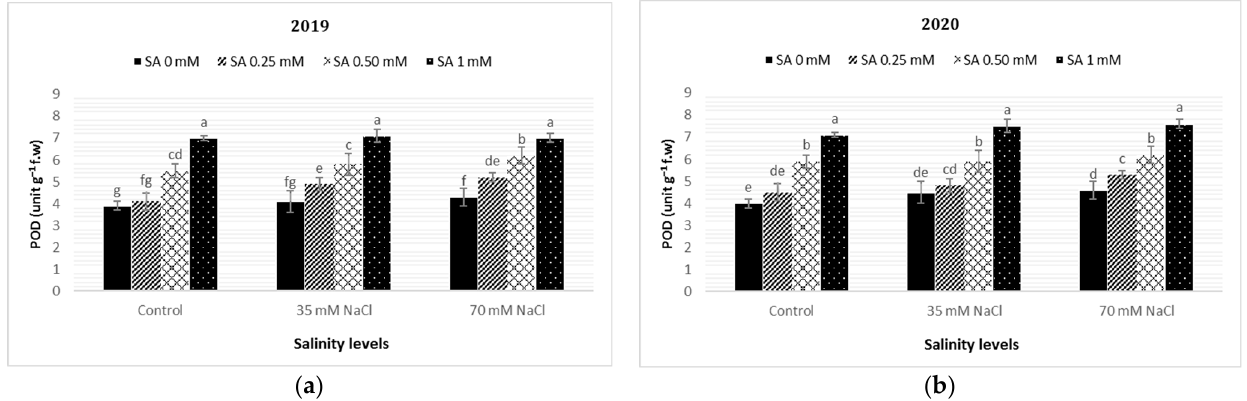
Figure 2. Peroxidase (POD) activity in pomegranate plants cv. “Wonderful” subjected to different salicylic acid (SA) treatments under salinity stress conditions in 2019 ( a ) and 2020 ( b ) seasons. The vertical bars with different letters are statistically different, indicating an interactive effect of salicylic acid treatments and salinity levels according to LSD test ( p < 0.05). Vertical bars indicate the mean ± SE.